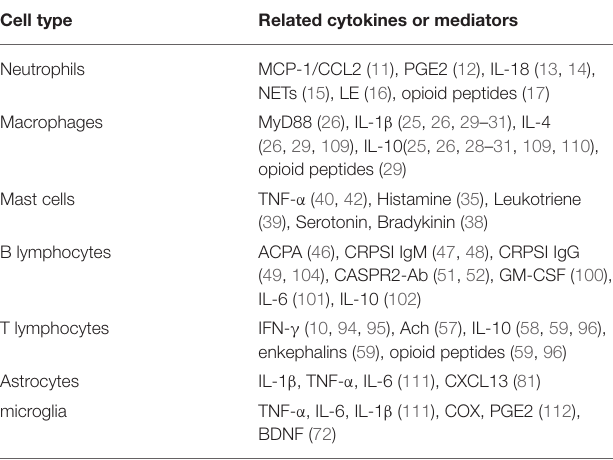
TABLE 1 | Relative cytokines of immune cells in the central and peripheral